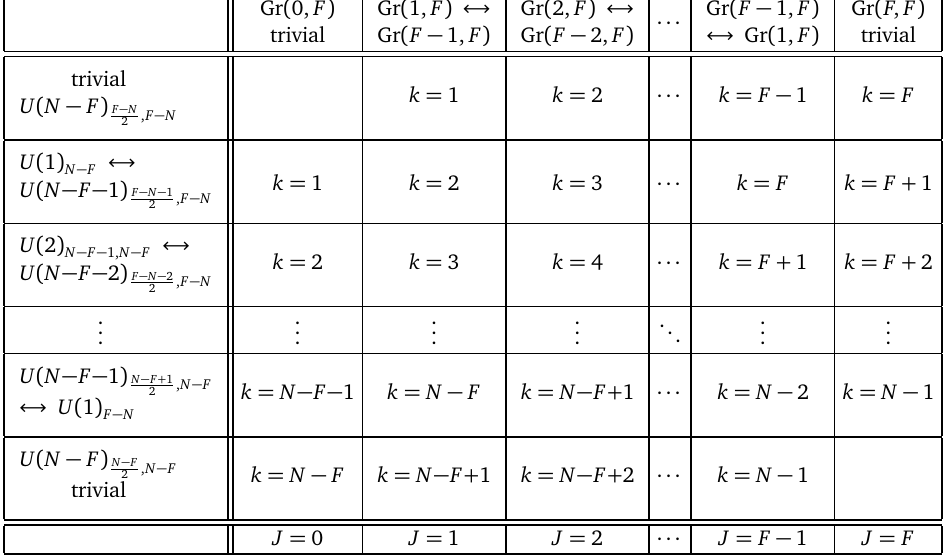
Table 1: Domain walls of massive SU ( N ) SQCD with F < N flavors and small m